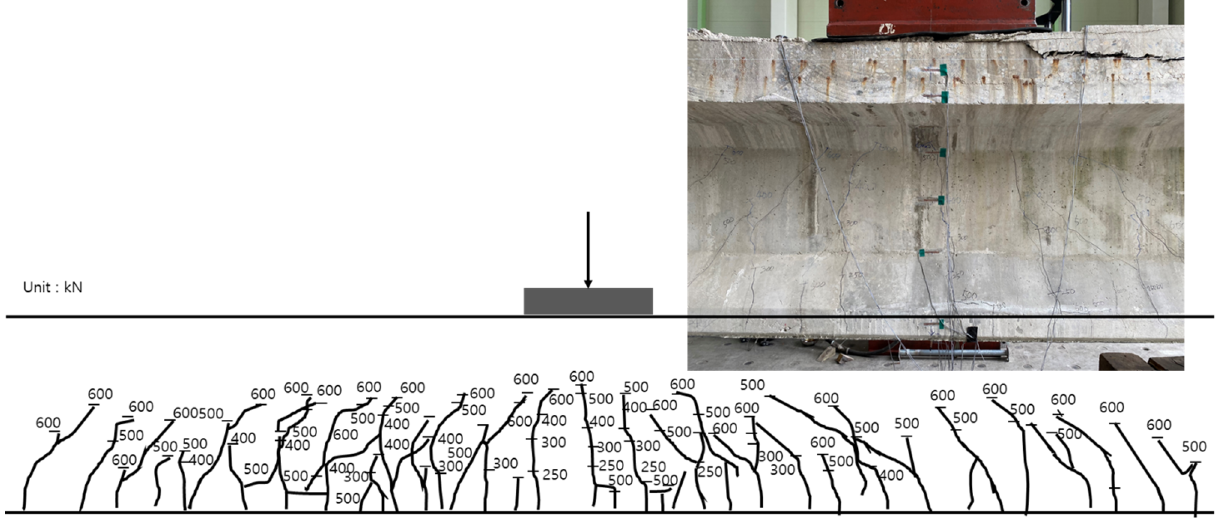
Figure 22. Crack map according to the load developed after reinforcement by the NSM method.